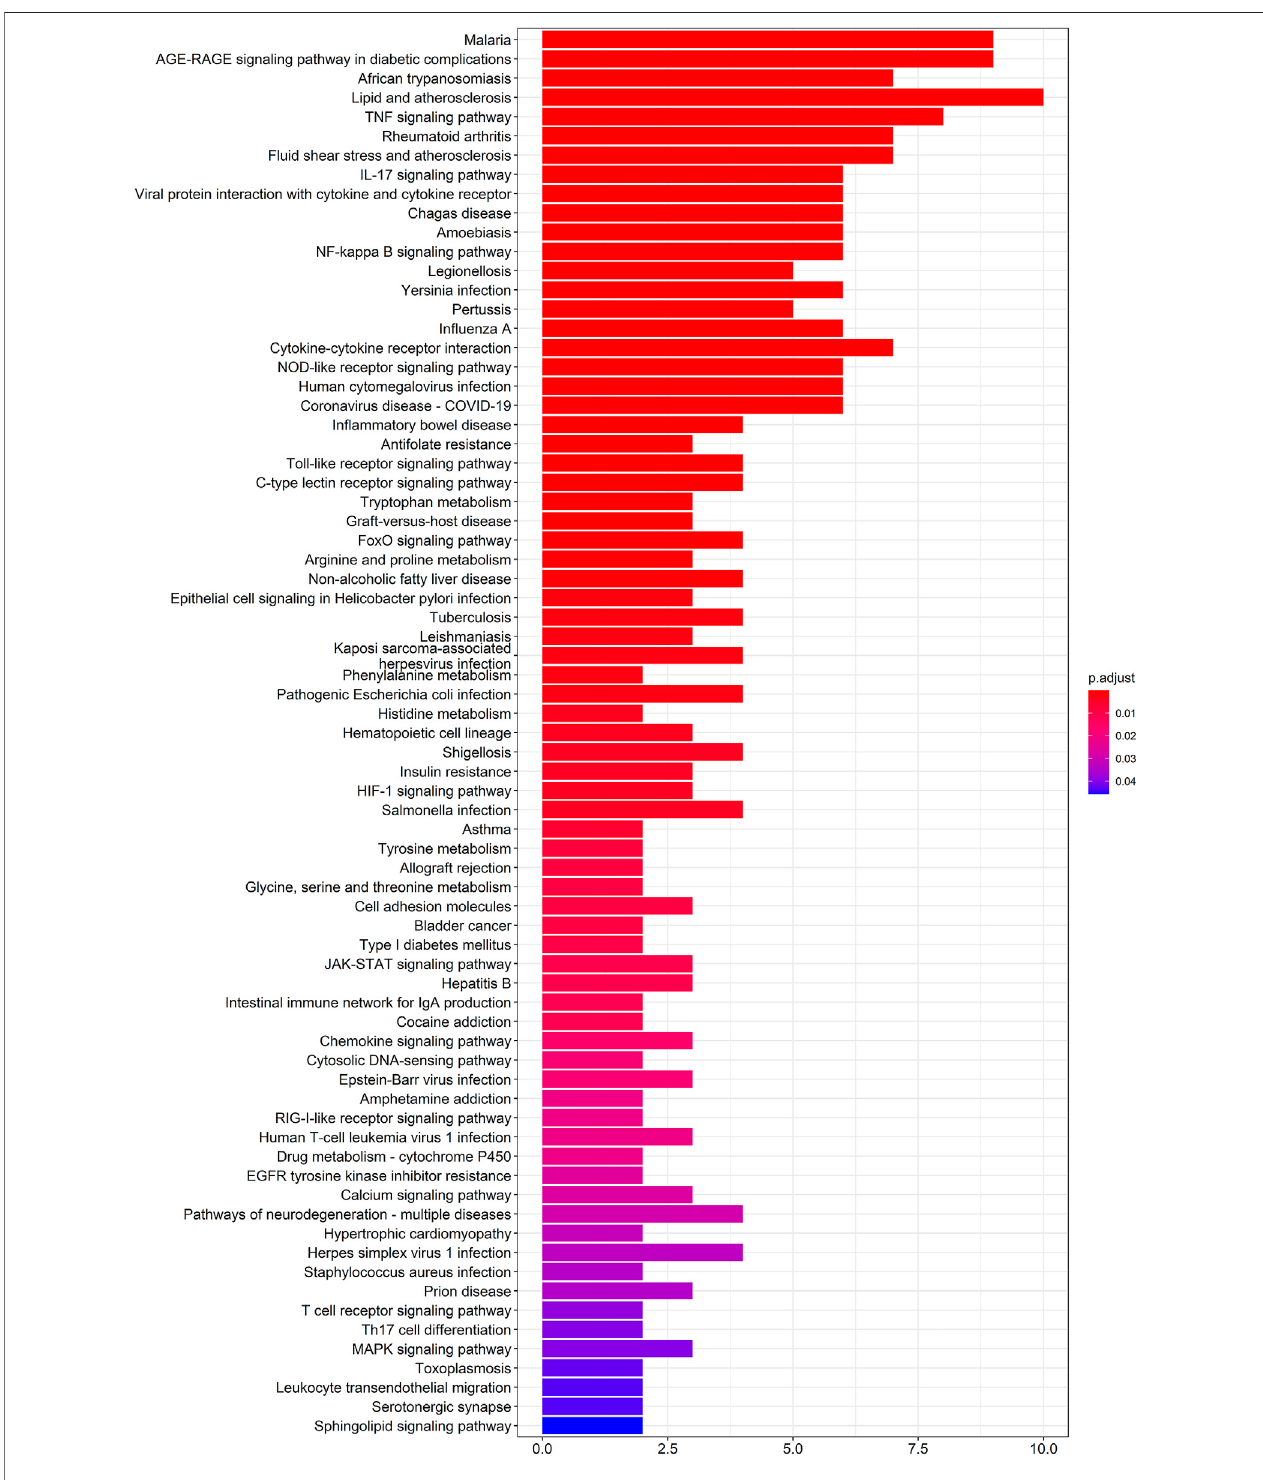
FIGURE 2 | Analyses of pathway enrichment using the KEGG database.